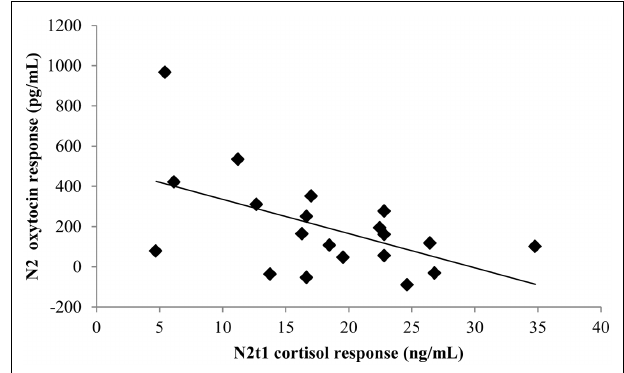
FIGURE 3 | Scatterplot of the relationship between the N2 oxytocin response to novelty and N2t1 cortisol levels.